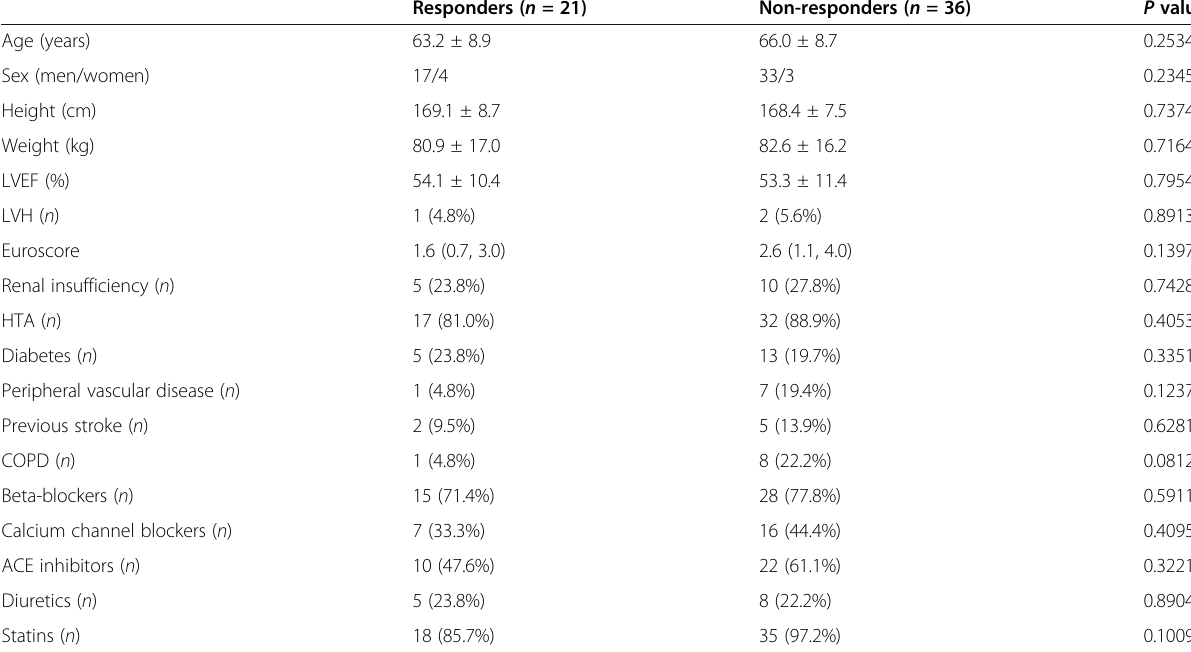
Table 1 Characteristics of responder and non-responder patients after fluid infusion and leg